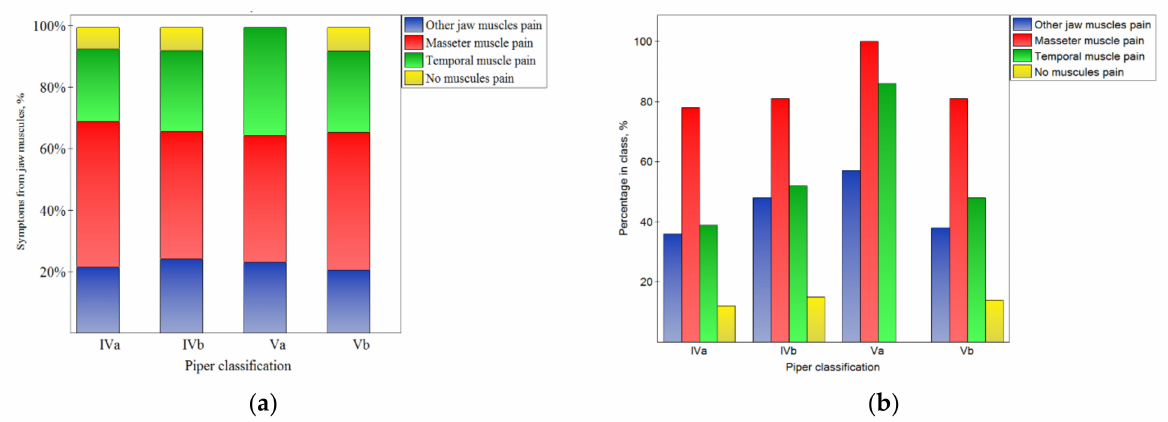
Figure 3. Impact of the Piper classification on the symptoms from muscles: the distribution of symptoms among the classes ( a ), and the percentage of symptoms in the number of noted cases for the particular classes ( b ).